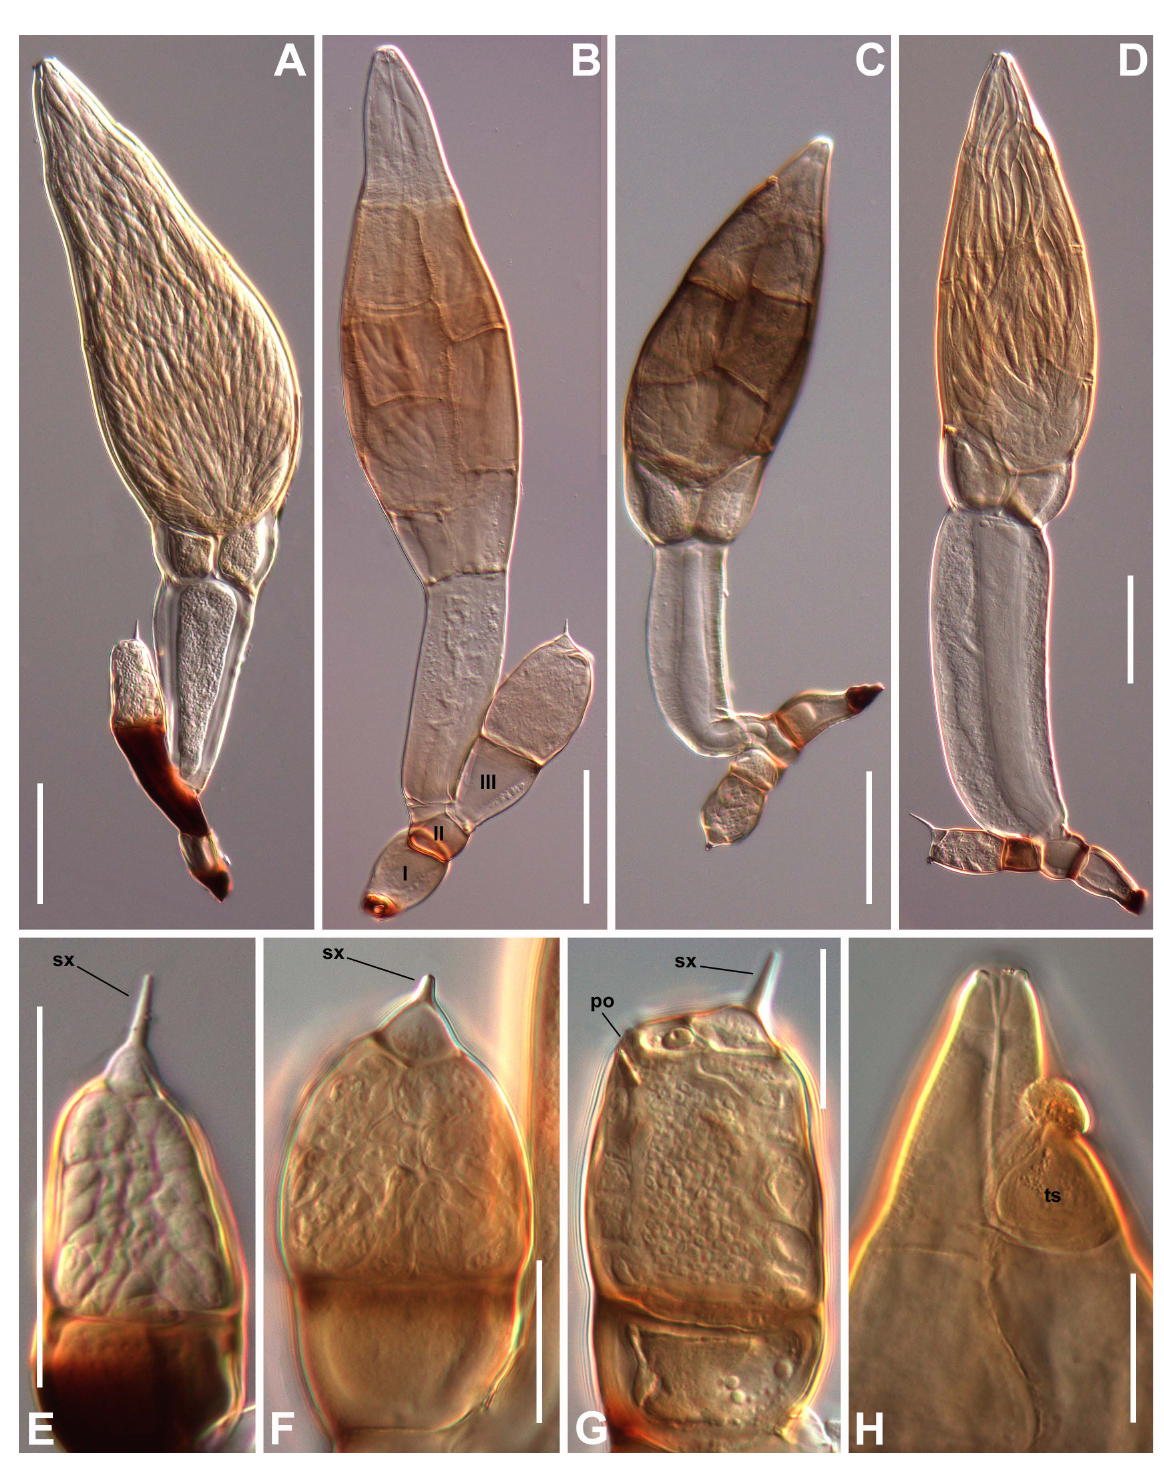
Fig. 79. Haplomyces texanus Thaxt. A – D . Mature thalli. In B, cells I, II, and III are labelled. E – G . Antheridia in detail showing the spinous process on the antheridium (sx) and the discharging pore (po) in G. H . Perithecial apex in detail showing conspicuous trichogyne scar (sc). Scale bars: 50 µm. Photographs from slides ZMUC C-F-124196 (A), ZMUC C-F-124192 (B), ZMUC C-F-124193 (C), ZMUC C-F-124201 (D), ZMUC C-F-124211 (E), ZMUC C-F-124212